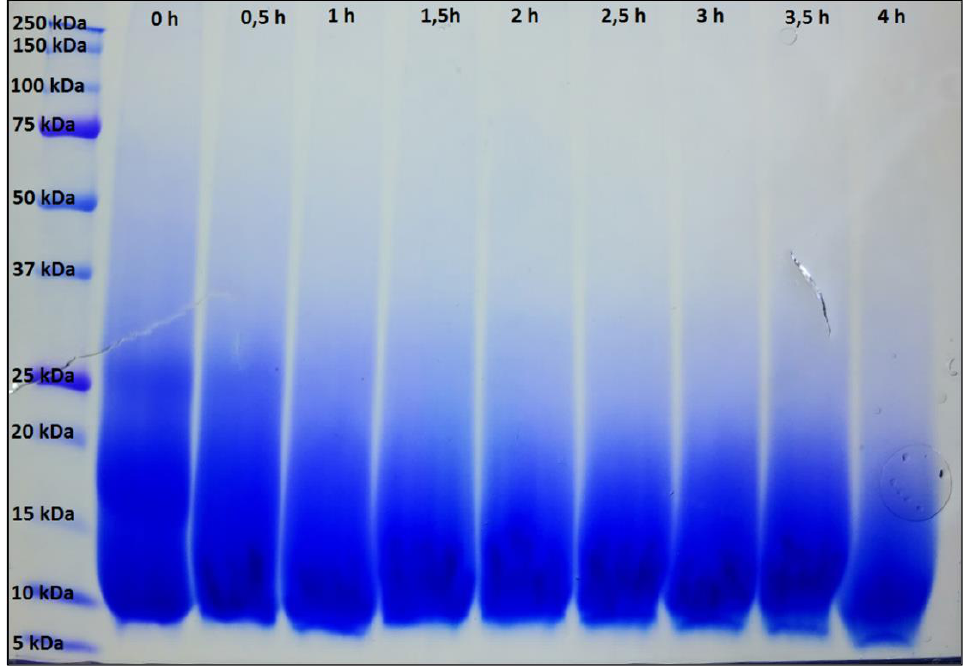
Figure 6. SDS-PAGE pattern of keratin solution with sodium sulphide at different times in the drying process at 70 °C. The left column shows the molecular weight standard. The lines next to the standard show the molecular weight of the standard for 0 to 4 h of the drying process.